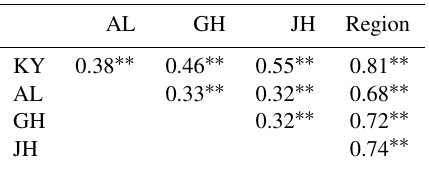
Table 2. Five-chronology correlation matrix over the common pe- riod (1793–2010). AL GH JH